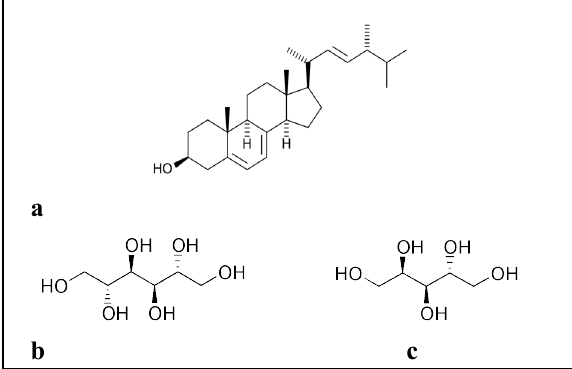
Fig. 1. Molecular structures of Ergosterol (a) Mannitol (b) and ara- bitol (c)